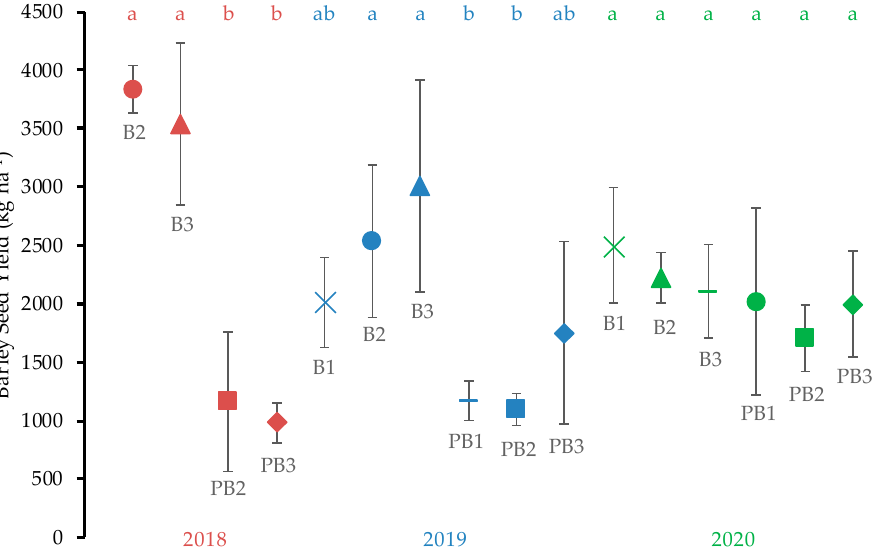
Figure 2. Barley seed yield as sole crop in two (B1, B2; 2018) and three (B1, B2, B3; 2019–2020) different seedings densities compared to barley yields from intercropping with poppy (PB1, PB2, PB3). Lower case letters indicate significant differ- ences between treatments in each year (ANOVA + Tukey HSD test).